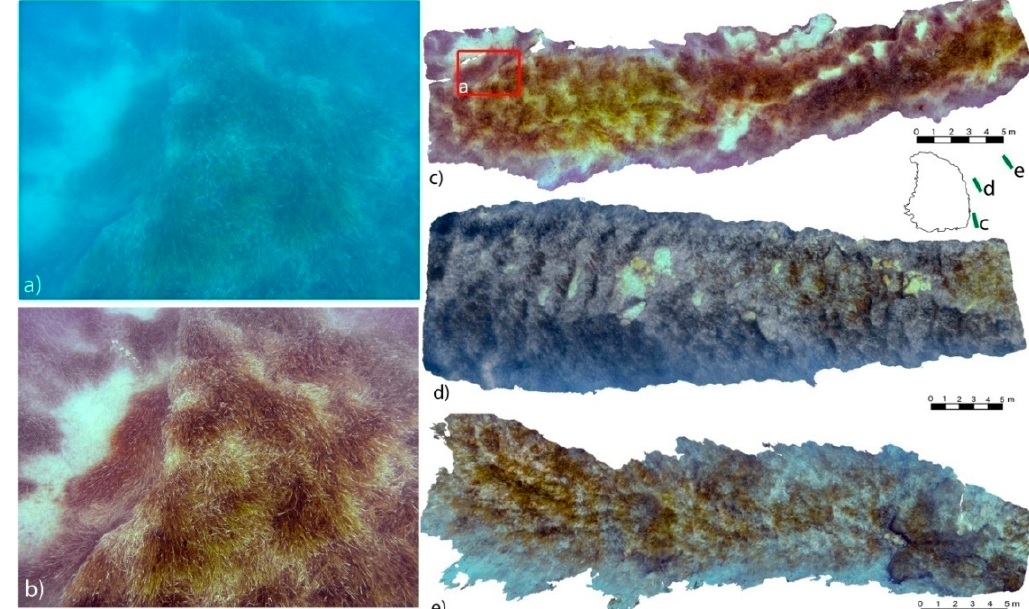
Figure 7. ( a ) Sample image before and ( b ) after the application of the image enhancement algorithm on a single frame of the underwater photogrammetric survey. Orthogonal view of the 3D point clouds of three sample areas: ( c ) area size: 35 m × 7 m, 13 million 3D points; ( d ) area size: 40 m × 7 m, 15 million 3D points; ( e ) area size: area size: 33 m × 9 m, 14 million 3D points. The map between ( c ) and ( d ) shows the location of the submerged transects with respect to Cirella Island.